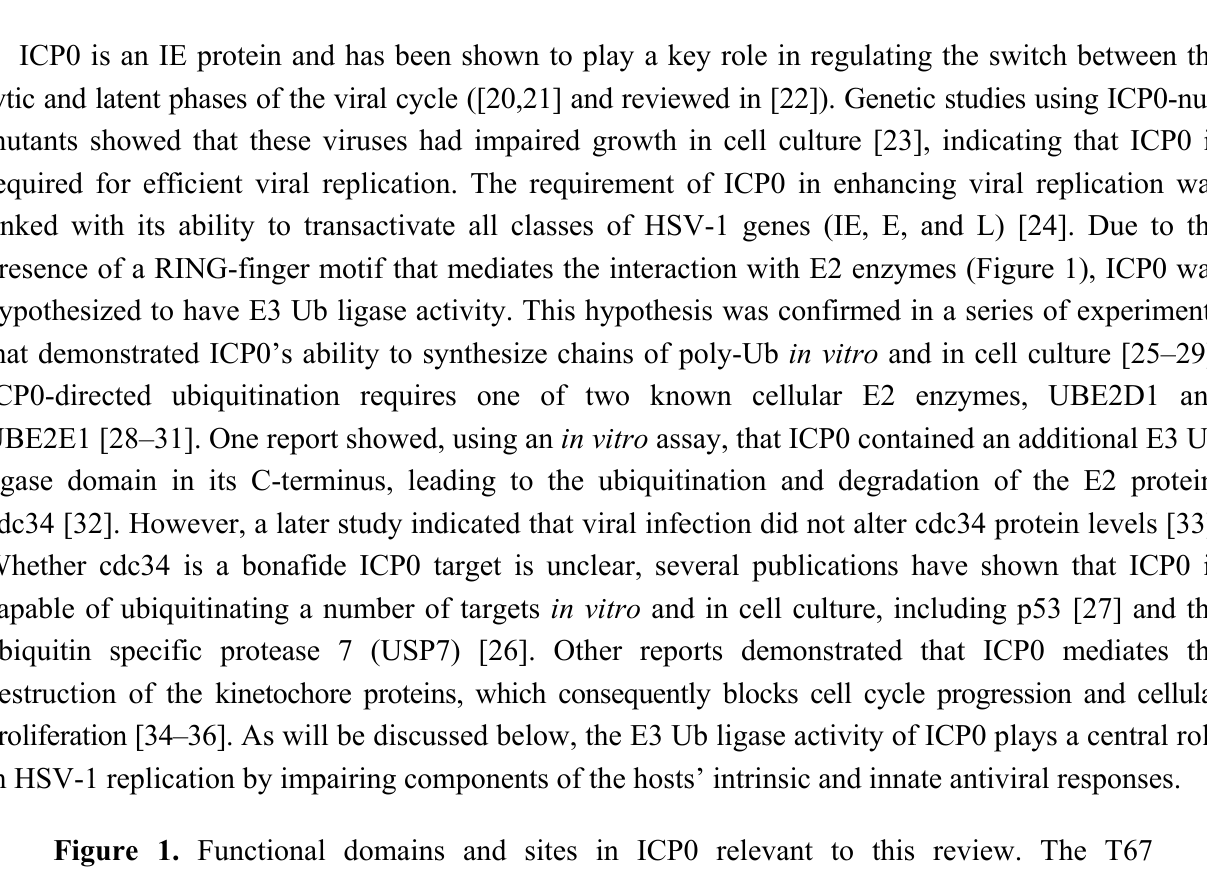
phosphorylation site, RING-finger motif, ICP0 phosphorylation (Phos) region I